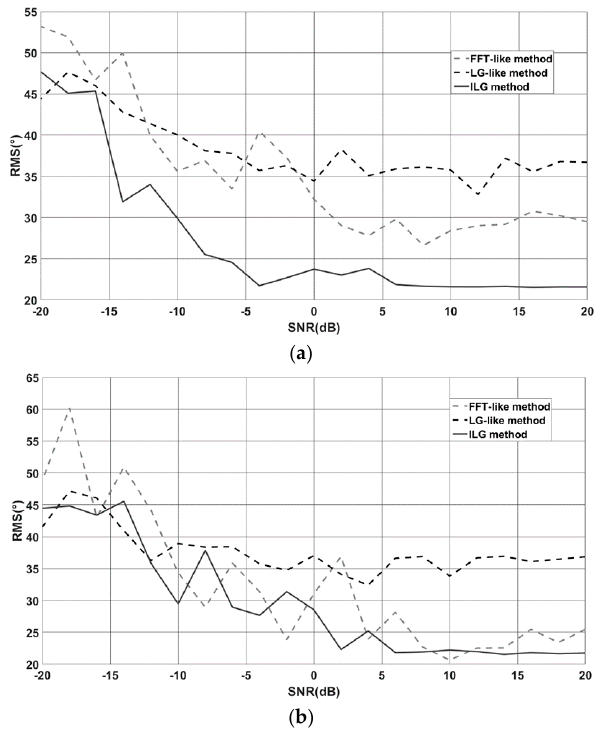
Figure 13. RMS differences between the retrieved results of each method and the interpolating wind directions when the additive noise exists with a different signal-to-noise ratio (SNR): ( a ) ECMWF and ( b ) CCMP.